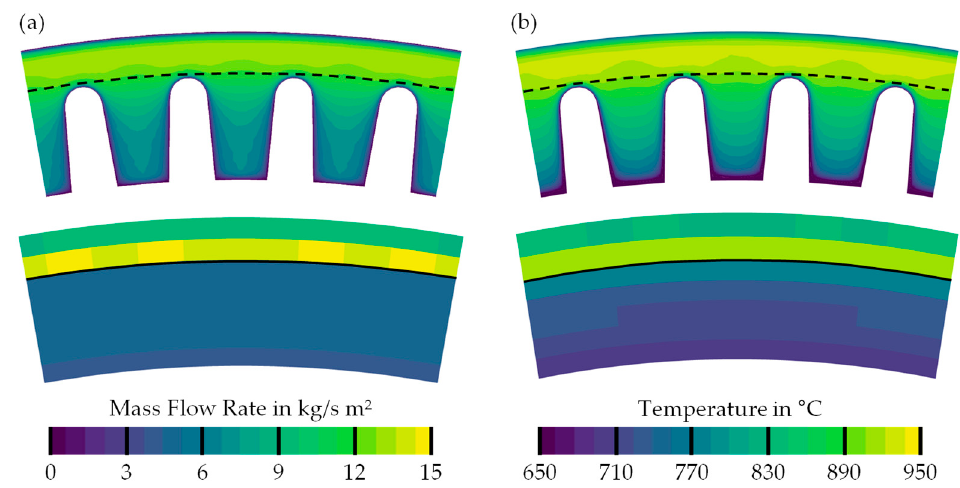
Figure 17. Mass Flow Rate ( a ) and Fluid Temperature ( b ) on the radial cross-section of the detailed ( top ) and simplified ( bottom ) geometry for P = 160 kW, λ = 1.15, and T o = 1000 °C.